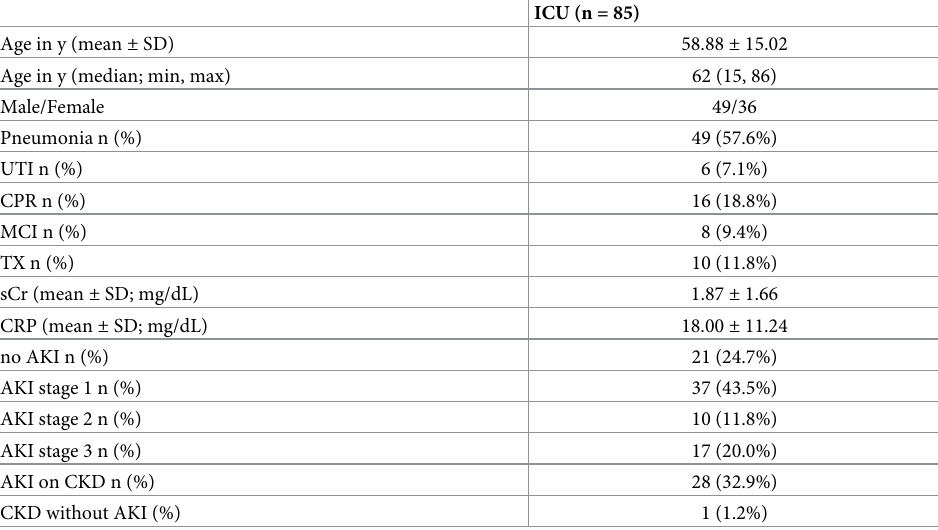
Table 2. Demographics and disease